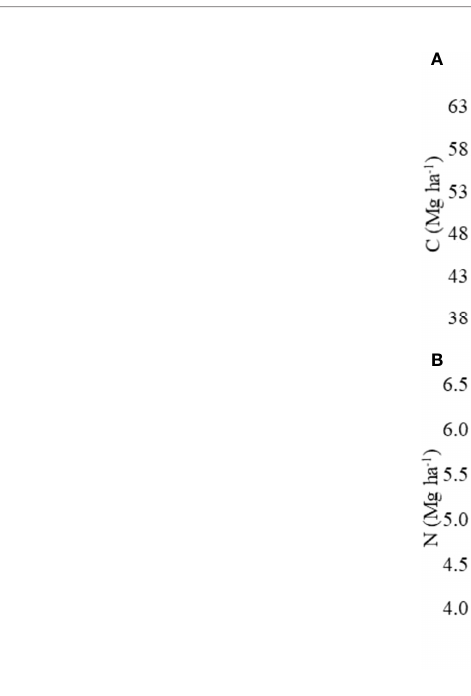
FIGURE 3 | Temporal change in (A) carbon and (B) nitrogen stocks in the 0-30 cm topsoil layer. CC – permanent conventional crop rotations (corn, winter wheat, and barley crops) and GG-permanent grassland. ns Not signi fi cant. *Signi fi cant in the Scott – Knott test (p ≤ 0.05). + Signi fi cant at p ≤ 0.01.